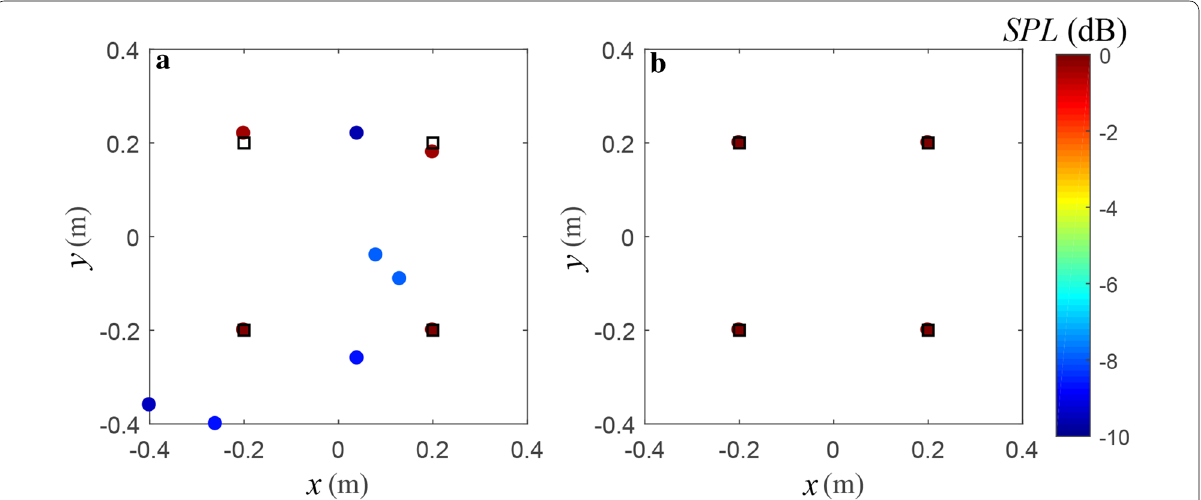
Figure 9 Source maps obtained by: a DCS-SOMP method, and b DCS-SOMP-SVD method as the target sparsity equals 10